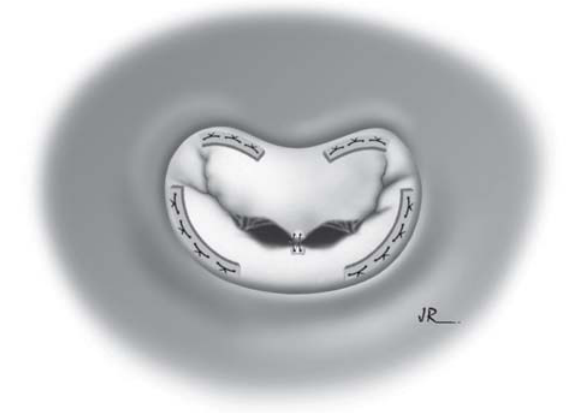
Fig. 2 – Plastia de Alfieri: Realiza-se aproximação de cúspide anterior e posterior no ponto de maior regurgitação, de modo a impedir prolapso das cúspides para além do plano